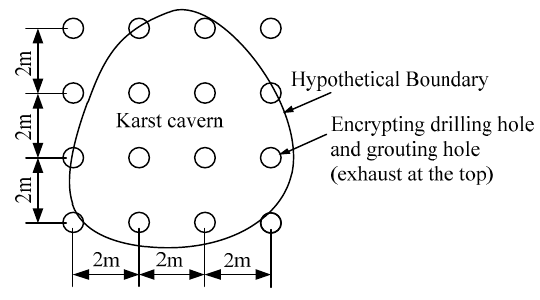
Figure 8. Layout of the grouting holes.